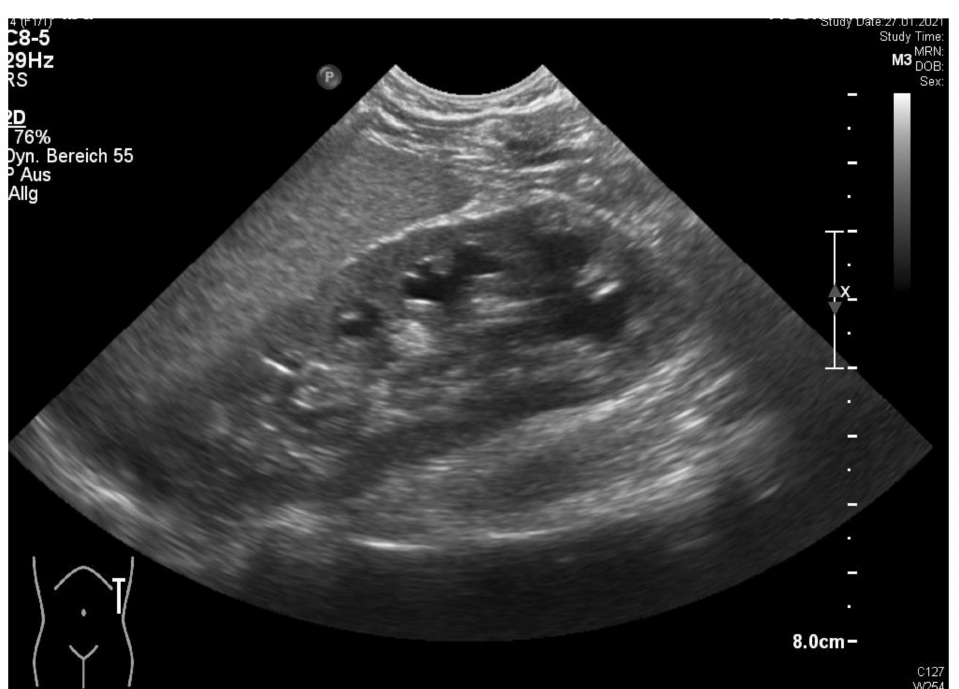
Figure 6. Ultrasound test after left-sided robotic pyeloplasty before dismission shows normal kidney without dilatation of the pyelon (courtesy of Dr. A. Longin, Klinikum